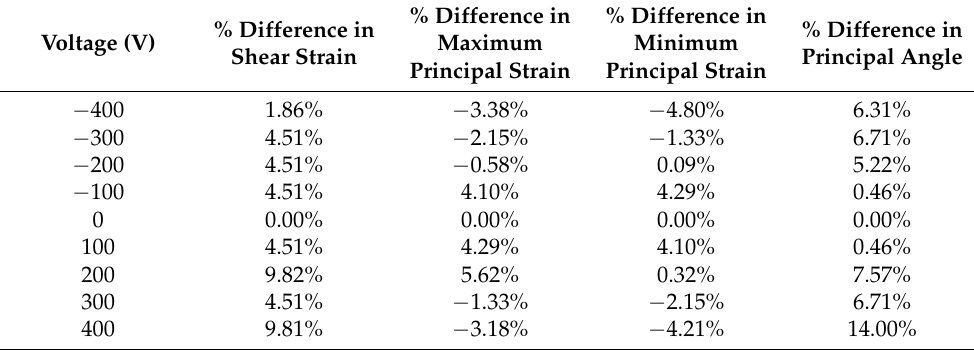
Table 4. Comparison between FE simulation and experimental results for applied voltage on MFC actuator.